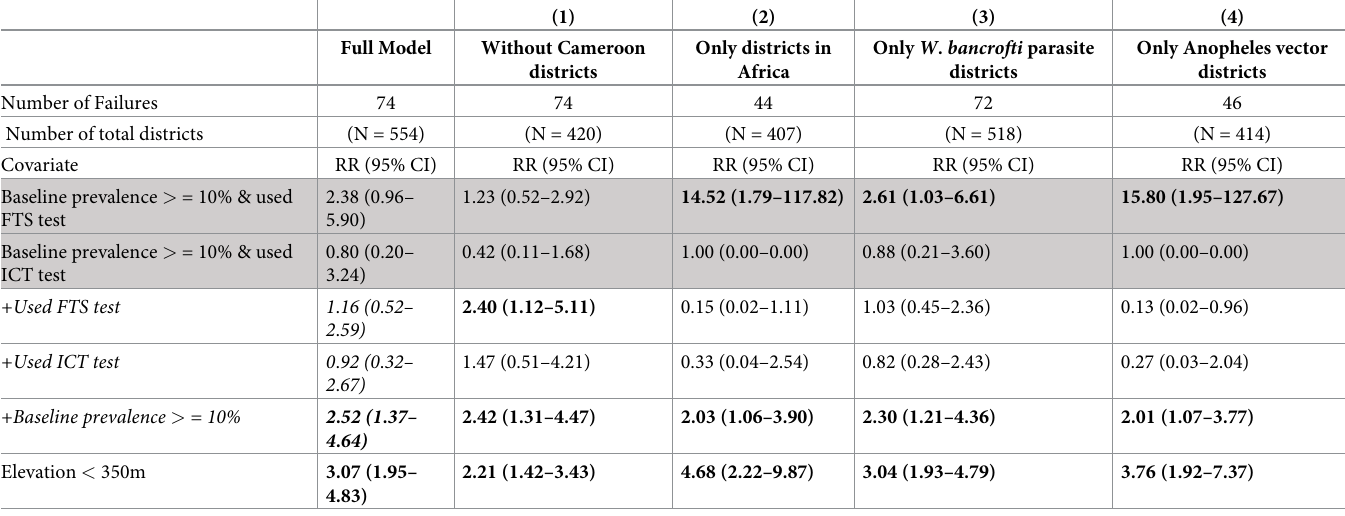
Table 2. Adjusted risk ratios for pre-TAS failure from log-binomial model sensitivity